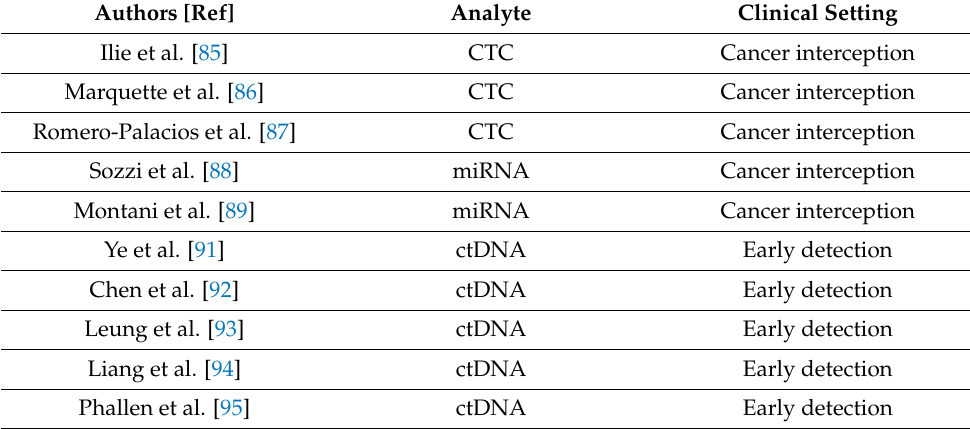
Table 1. Summary of studies adopting different analytes from blood